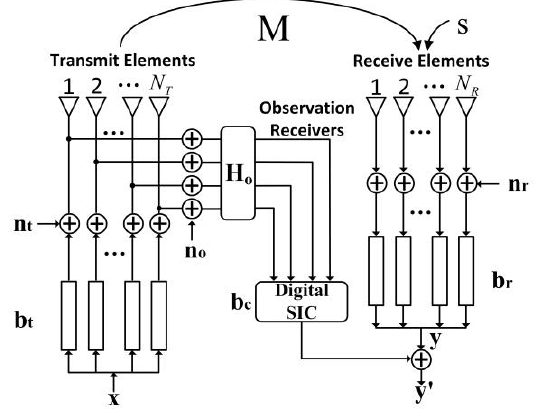
Figure 1. FD-ALSTAR structure.